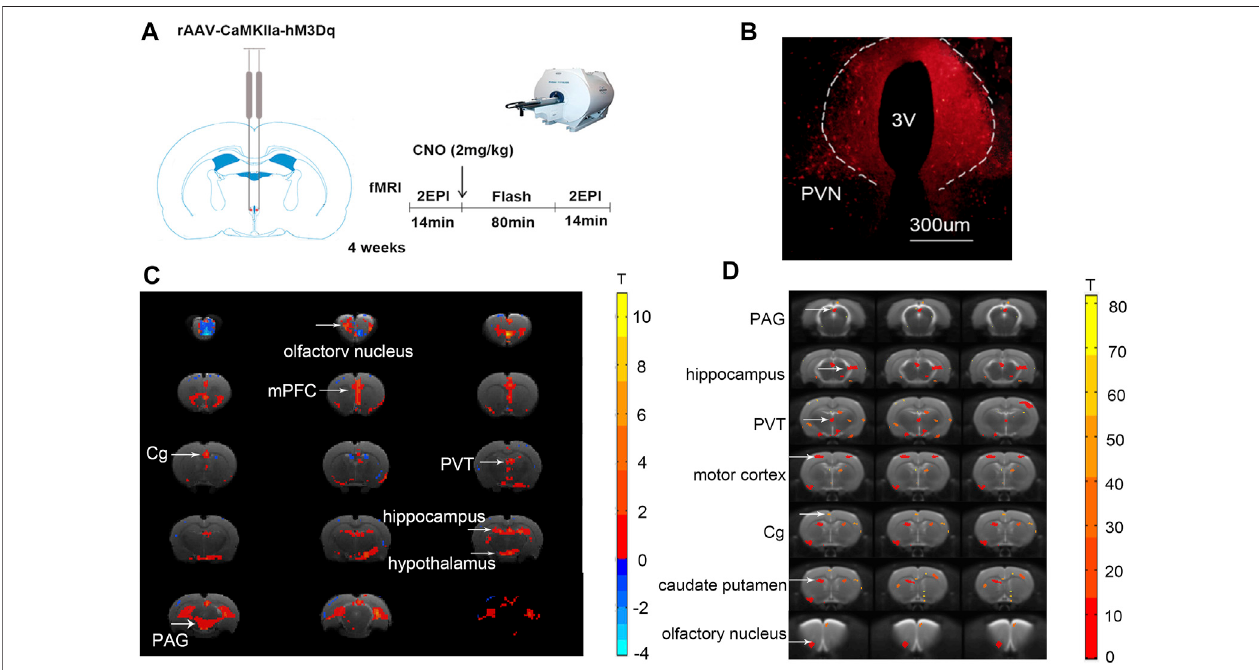
FIGURE 1 | Chemogenetic activation of the PVN glutamatergic neurons alters BOLD signals and functional connectivity in the brain. (A) The schematic diagram of chemo-fMRI scanning. (B) The image showed the expression of the hM3Dq-mCherry virus in PVN. (C) The BOLD signals of the PVN, mPFC, Cg, PVT, PAG, and the hippocampus increased after chemogenetic activation of the glutamatergic neurons of PVN. (D) The functional connectivity of the PVN and the mPFC, Cg, PVT, PAG, motor cortex, caudate-putamen, hippocampus increased after chemogenetic activation of the glutamatergic neurons of PVN ( n = 7. Paired t -test, FDR p ＜ .05).